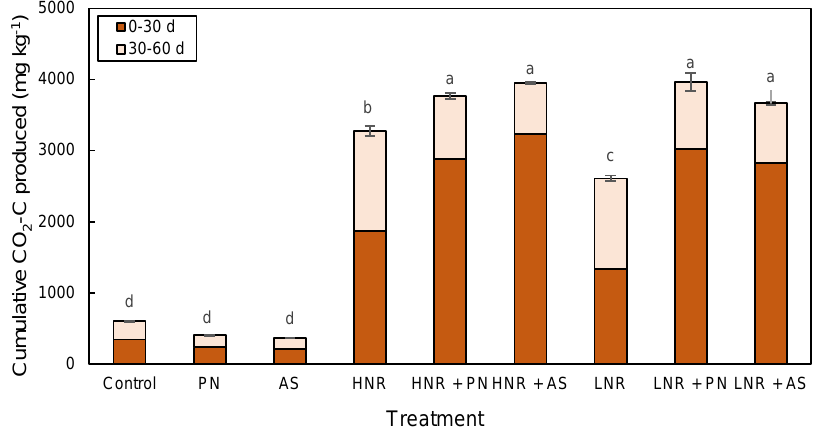
Figure 3. Cumulative CO 2 -C produced by soil during half or all of a 60 d aerobic incubation involving an unamended control and the following eight treatments: potassium nitrate (PN), ammonium sulfate (AS), high N residue (HNR) with or without PN (HNR + PN) or AS (HNR + AS), and low N residue (LNR) with or without PN (LNR + PN) or AS (LNR + AS). Data shown as a mean from triplicate incubations with standard error bars obtained for the total amount of CO 2 collected. Treatments do not differ significantly ( p < 0.05) for the entire 60 d incubation period when bars are accompanied by the same letter.